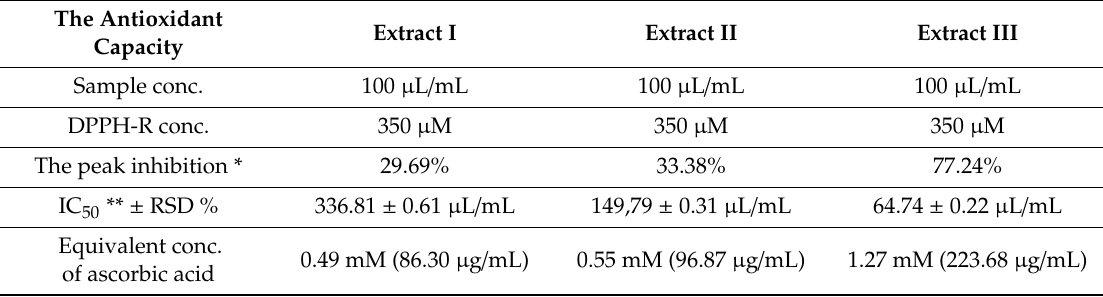
Table 4. The IC 50 of plant extracts estimation by DPPH-HPLC-DAD at 517 nm. DAD: diode array detector. The Antioxidant Extract I Extract II Extract III Capacity Sample conc. 100 µ L / mL 100 µ L / mL 100 µ L / mL DPPH-R conc. 350 µ M 350 µ M 350 µ M The peak inhibition * 29.69% 33.38% 77.24% IC 50 ** ± RSD % 336.81 ± 0.61 µ L / mL 149,79 ± 0.31 µ L / mL 64.74 ± 0.22 µ L / mL Equivalent